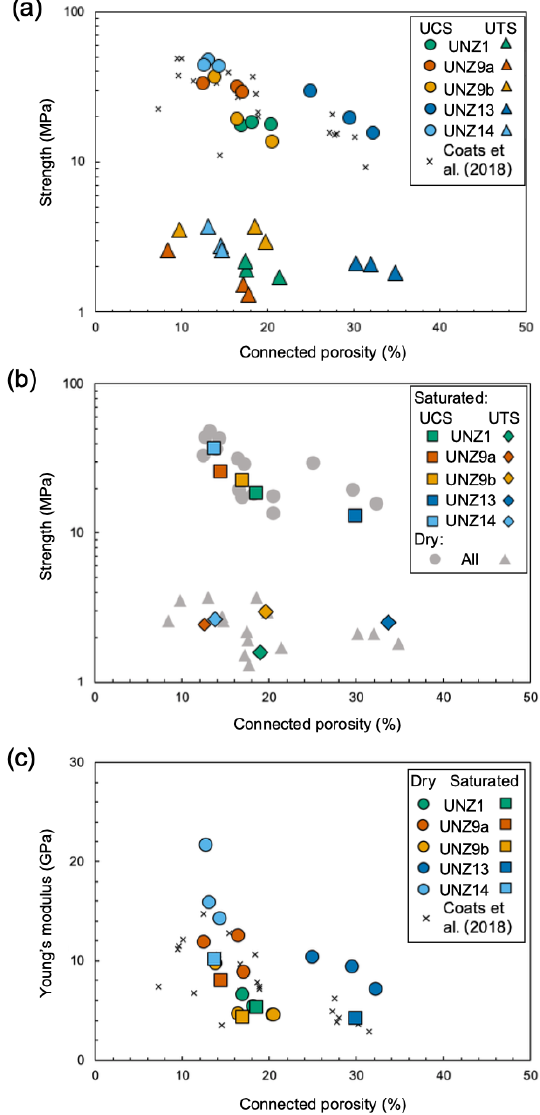
Figure 6. Mechanical data for (a) dry compressive (UCS) and ten- sile (UTS) strength tests, plotted with comparable tests on Unzen dacite from Coats et al. (2018), as a function of connected porosity; (b) saturated tests of compressive (UCS) and tensile (UTS) strength as a function of connected porosity, with dry tests from panel (a) plotted in greyscale for comparison; (c) Young’s modulus calcu- lated from UCS data for dry and saturated samples, plotted with comparable measurements from Coats et al. (2018), as a function of connected